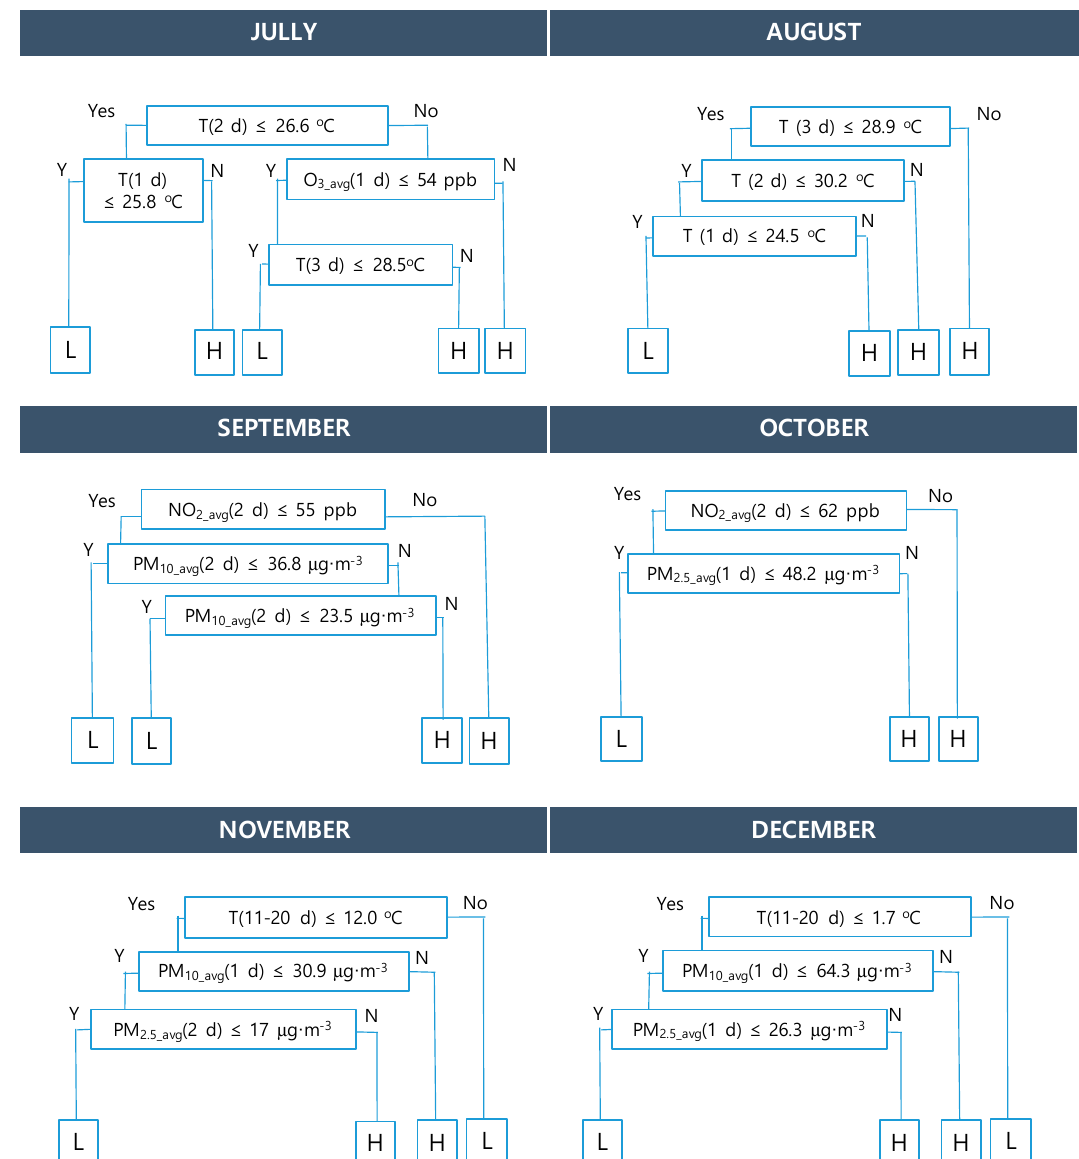
Figure 9. Daily average pollutant concentrations and temperatures affecting the high (H) and low (L) probability of deaths from respiratory disease. Table 2. Ten-fold cross validation errors from using a decision tree model to predict higher or lower probability of death from respiratory disease.